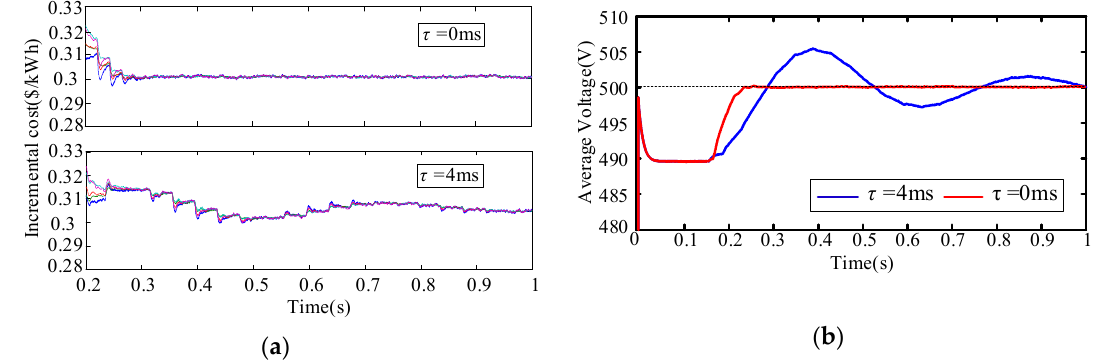
Figure 16. Performance of the common topology. ( a ) the incremental costs under different delays; ( b ) the average voltages under different delays.